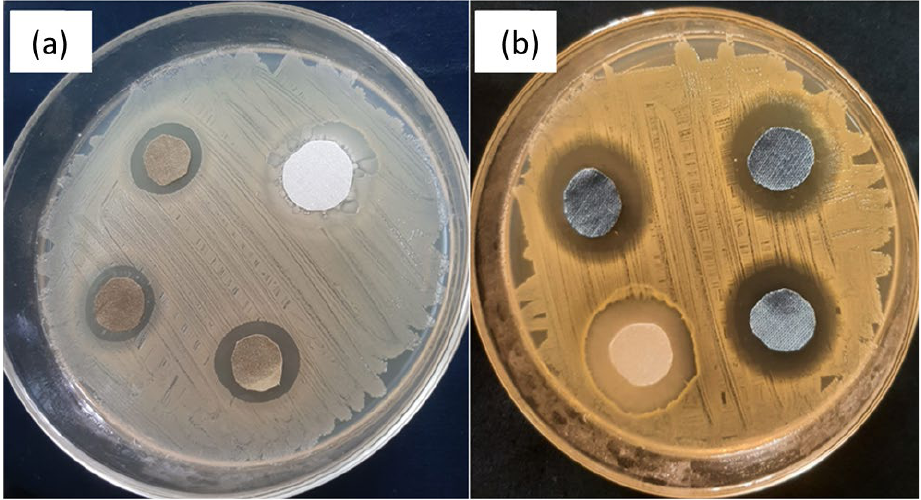
Figure 10. ZOI around ( a ) copper-coated fabrics and ( b ) copper-coated dyed fabrics against S-aureus. Table 6. The values of zone of inhibitions for developed samples against S. aureus and E. coli. Sr.#